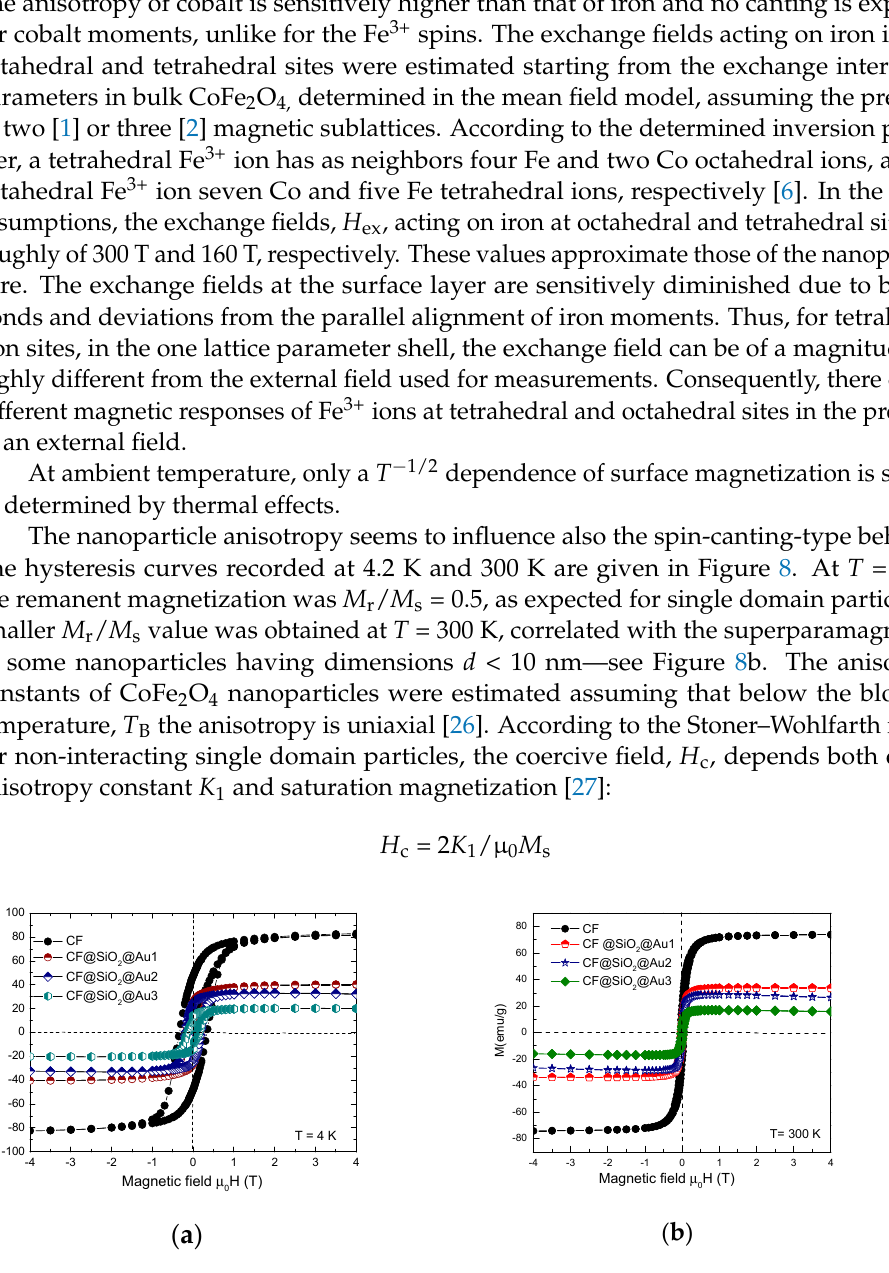
Figure 8. Hysteresis loops of CoFe 2 O 4 @SiO 2 @Au nanoparticles at T = 4.2 K ( a ) and T = 300 K ( b